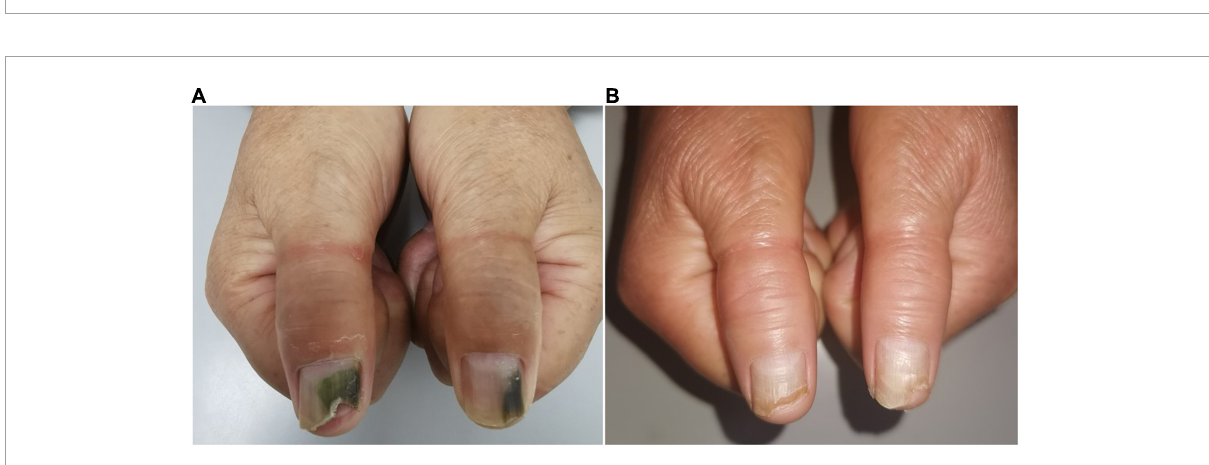
FIGURE3 Clinical image of Case 3. (A) Nail plate of a patient with onychosis-related GNS at initial visit. (B) Improved lesions at 2 months following chemical nail avulsion combined with topical antibiotic treatment.